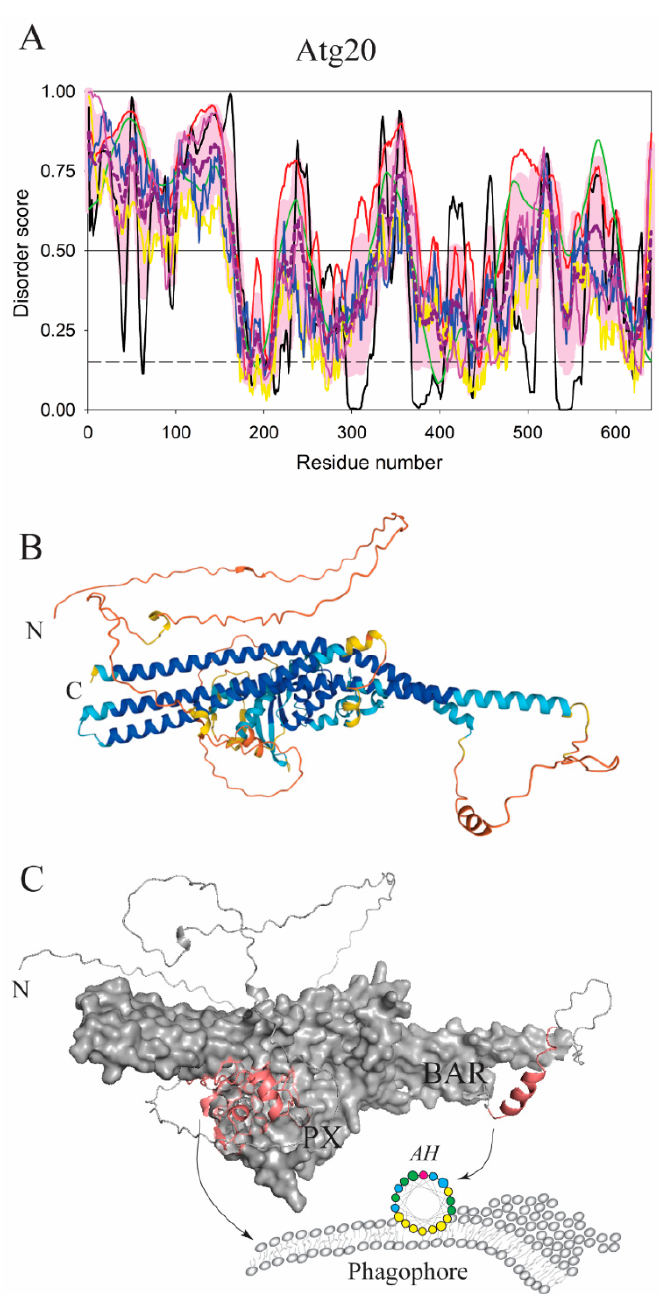
Figure 3. Atg20 is a structurally unique Phox homology-Bin/Amphiphysin/Rvs (PX-BAR) sorting nexin in autophagy. ( A ) Bioinformatic analysis of the Atg20 from yeast S. cerevisiae (for keys, see legend to Figure 2) showed a disordered score for the intrinsically disordered N-terminus (residues 1–160), a flexible loop called the PX-GAP in the PX domain (residues 161–297), the disordered linker between the PX and BAR domains (residues 298–358), and the unstructured BAR-GAP in the BAR domain (residues 359–636). Based on its overall disorder content of 67.3%, Atg20 belongs to the category of highly disordered proteins. ( B ) The AlphaFold model of Atg20 with color-coded modeling confidence. Very high confidence, blue; high confidence, cyan; medium confidence, yellow; low confidence, orange. ( C ) Protein surface rendering of the Atg20 model from B. The structured regions of the PX and BAR domain are denoted in black, and the membrane-binding segments in the PX and BAR domains are highlighted in dark